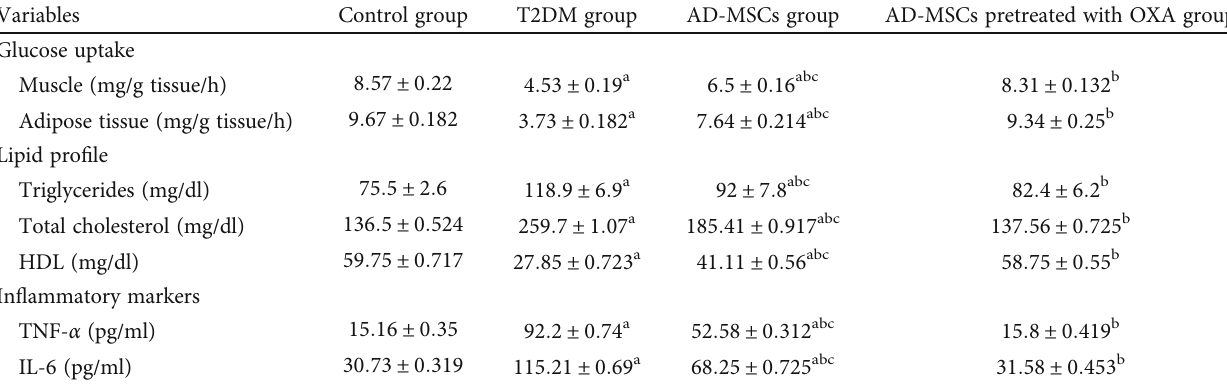
Table 3: Levels of glucose uptake, lipid pro fi le, and in fl ammatory markers in di ff erent study groups. Variables Control group T2DM group AD-MSCs group AD-MSCs pretreated with OXA group Glucose uptake